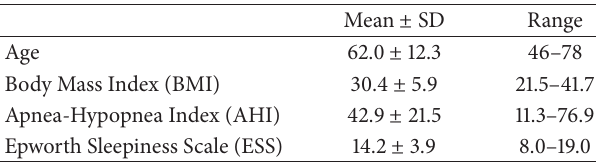
Table 1: Baseline